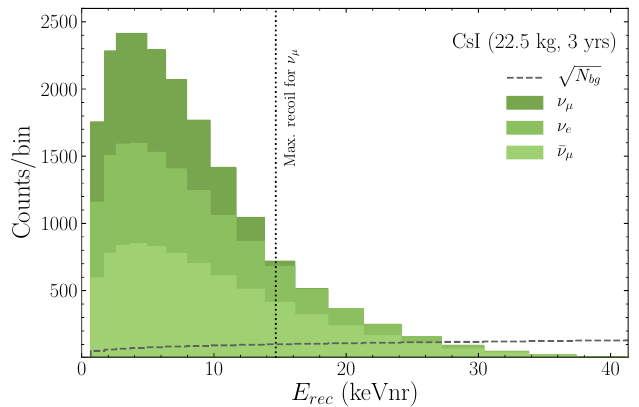
Figure 13 . Expected event rates per bin in nuclear recoil energy, for the CsI detector. The contri- butions from the scattering of the di(cid:11)erent beam components are shown separately by the shaded histograms, as indicated by the legend. For comparison, the square root of the number of back- ground events in each bin is also shown by the dashed histogram lines. The vertical dotted line indicates the maximum recoil energy allowed by a neutrino with energy E (cid:23) = 29 : 8 MeV, that is, the energy of the monochromatic prompt (cid:23) (cid:22) (cid:13)ux.